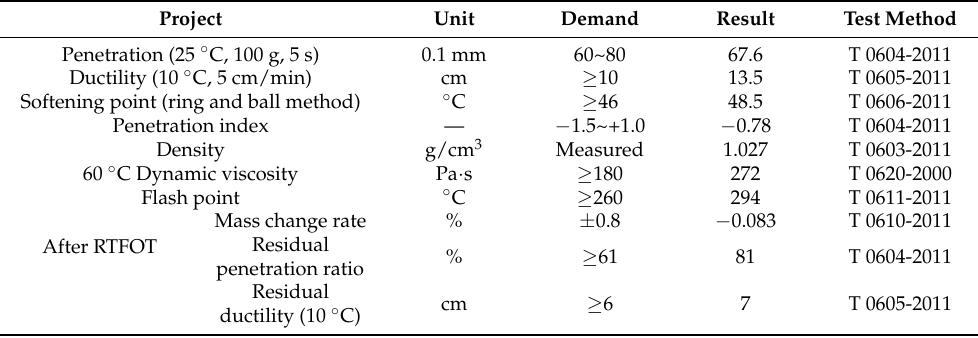
Table 1. Basic properties of